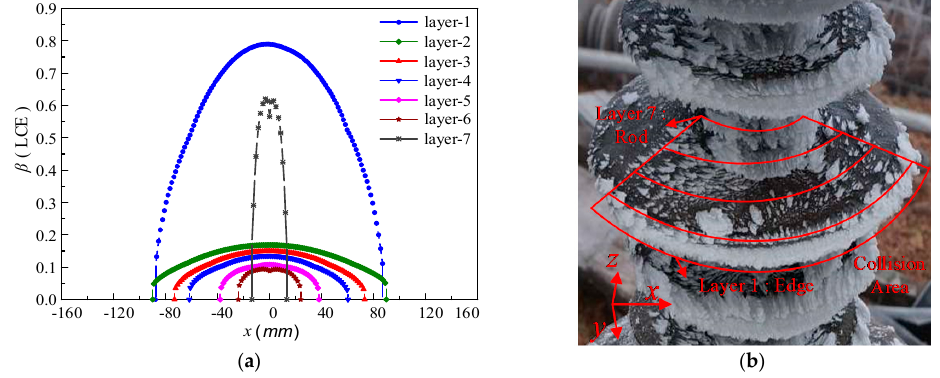
Figure 3. The LCE β 1 of different layers on the bigger shed of insulator type A (average diameter of water droplets ( D w ) = 80 μ m, U = 10 m/s). ( a ) The LCE β 1 and ( b ) separated layers of the insulator. The layers close to the insulator edge are more likely to have a larger β 1 , but all these values are lower than 0.2 ( β 1(Layer-2) > β 1(layer-6) ). In addition, the collision area decreases with decreasing layer